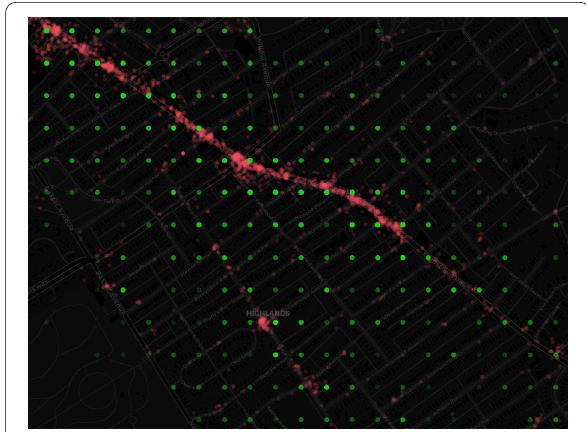
Fig. 1 Raw GPS (red) versus binned (green) departure and arrival location of a